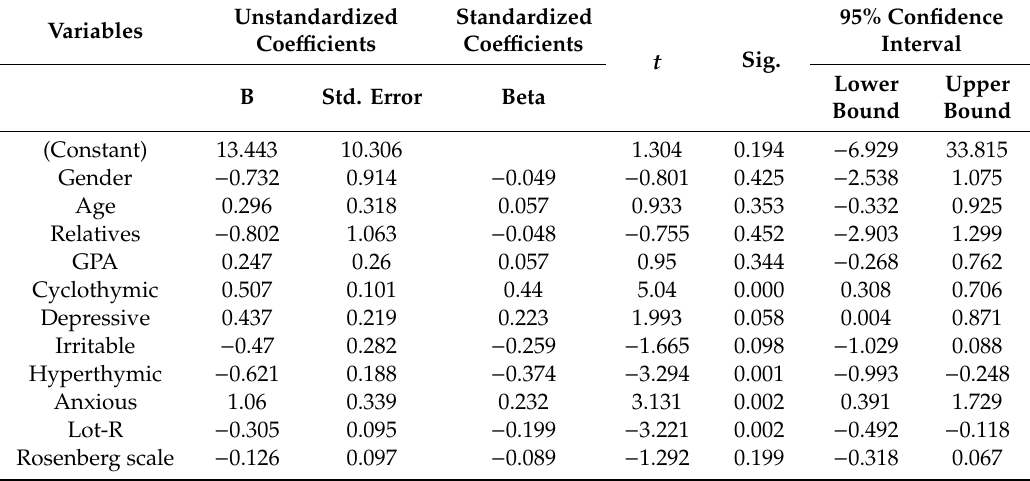
Table 2. Multiple regression analysis (Model 1). Predictors of perceived stress in allopathic medical